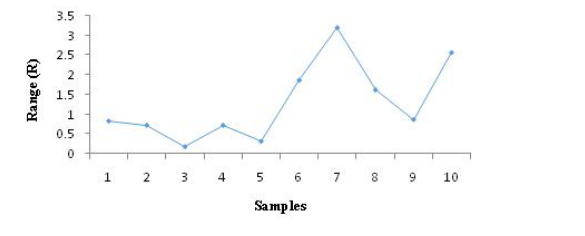
Figure 5: Range values (M) of the different samples